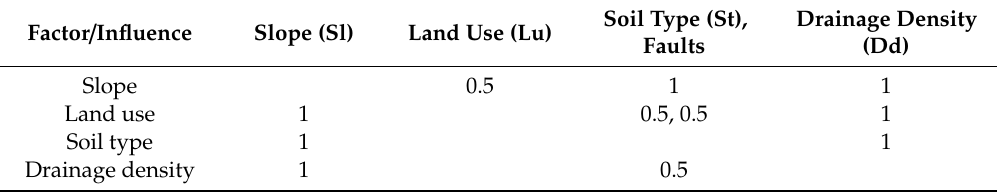
Table 2. Estimations of recharge influence among